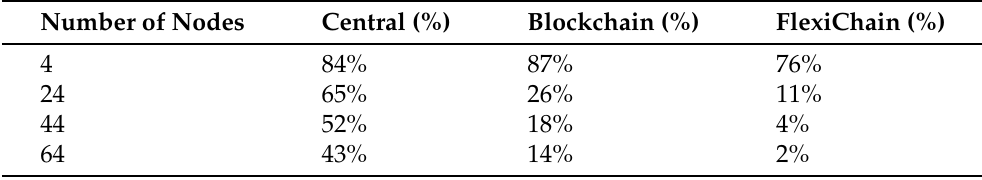
Table 7. Comparative Analysis between Central Versus Blockchain Versus FlexiChain: This ta- ble shows the probabilities acquired from our security analysis for three categories of attacks for three scenarios.